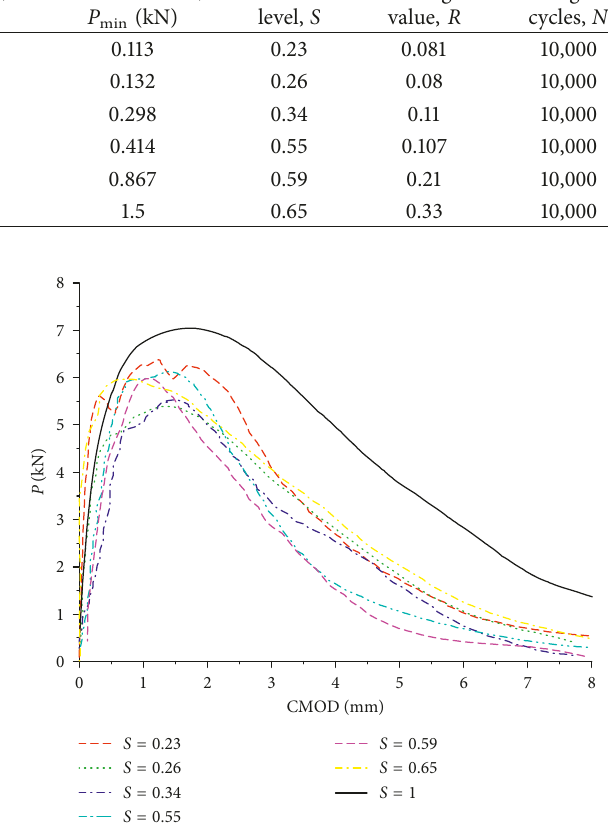
Figure 6: Evolution of CMOD during the dynamic test. Figure 7: Evolution of CMOD curves after the dynamic